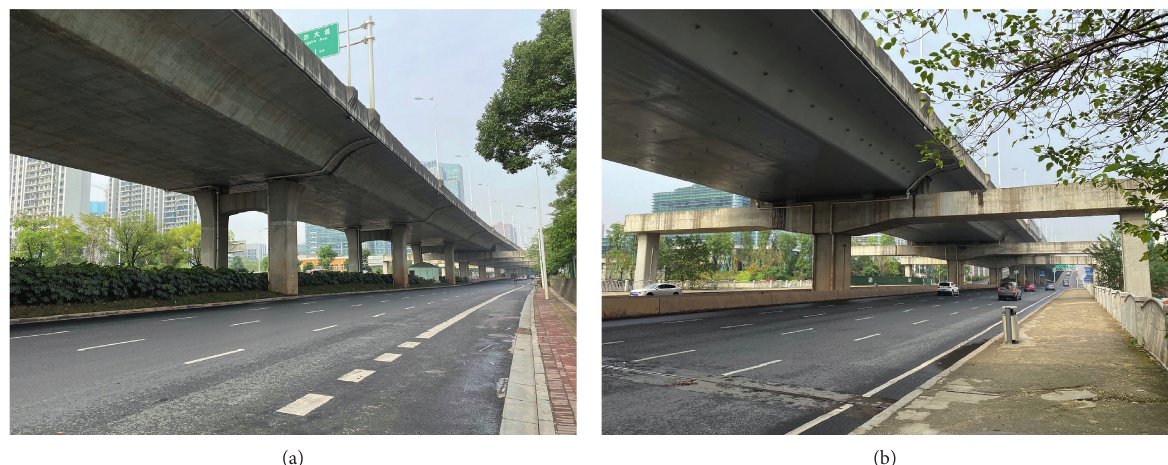
Figure 3: Comparison of site viaduct pile layout. (a) Normal. (b) Across the